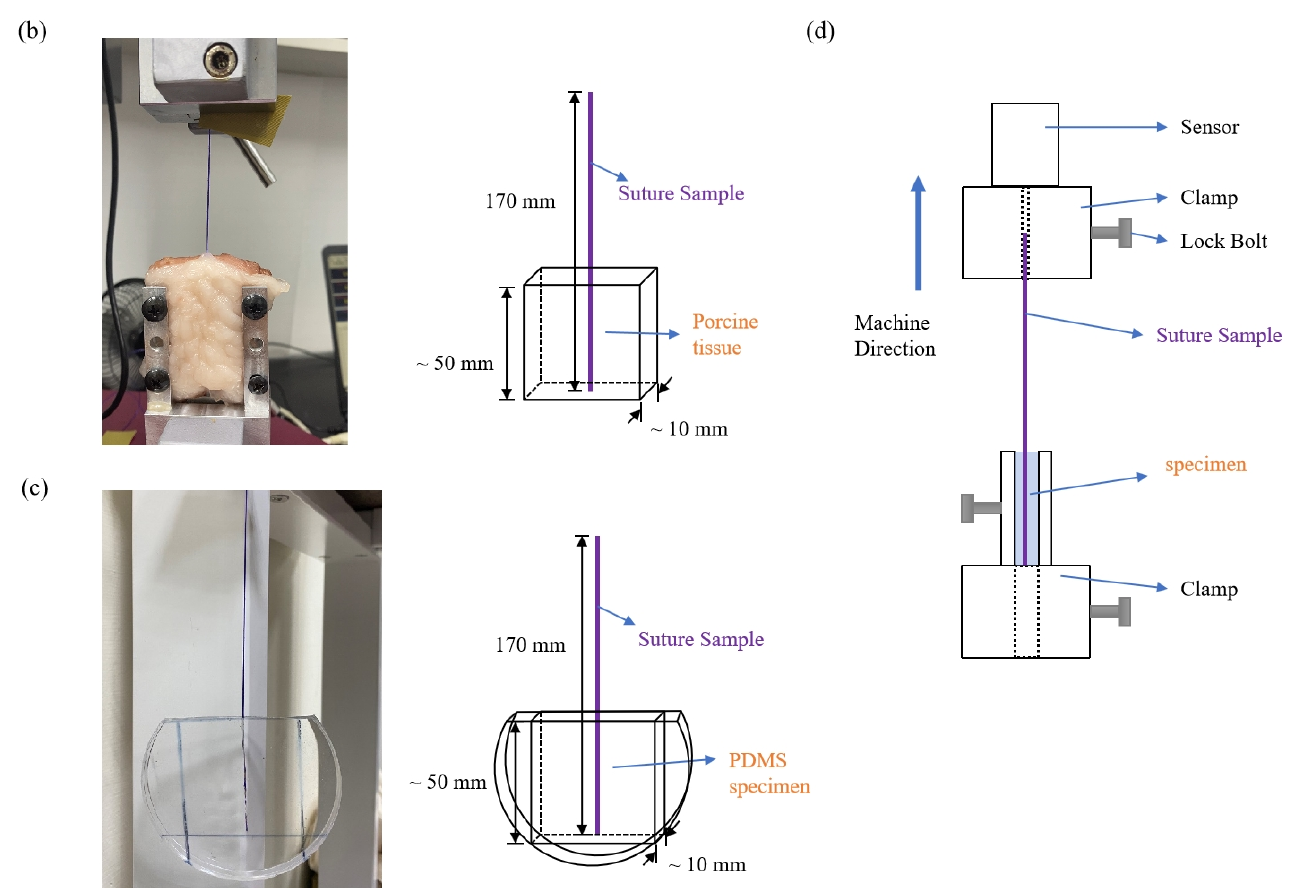
Figure 1. ( a ) The magnified image of the barbed suture. The distance between the barbs is 0.95 mm, on average (red double arrow). ( b ) A photo/diagram of porcine specimen inserted with suture sample. The tissue sample was cut into a rectangular prism (50 mm × 50 mm × 10 mm) for the pull ‐ out test. ( c ) A photo/diagram of PDMS specimen inserted with suture sample. The PDMS specimen was molded and cured in a Petri dish. ( d ) For suture pull ‐ out test, the specimen and suture were set up as the graph shows.